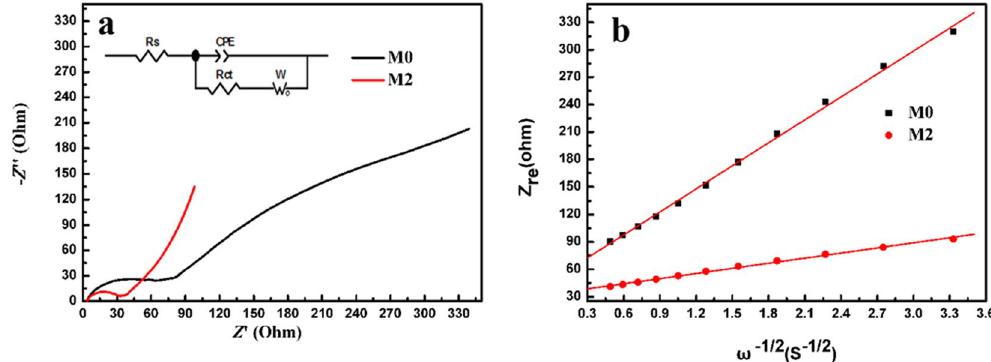
Figure 5. ( a ) Nyquist plots of M0 and M2 electrodes. The inset image is the corresponding equivalent circuit. ( b ) Relationship between Z re and ω − 1/2 of M0 and M2 electrodes at low frequencies.